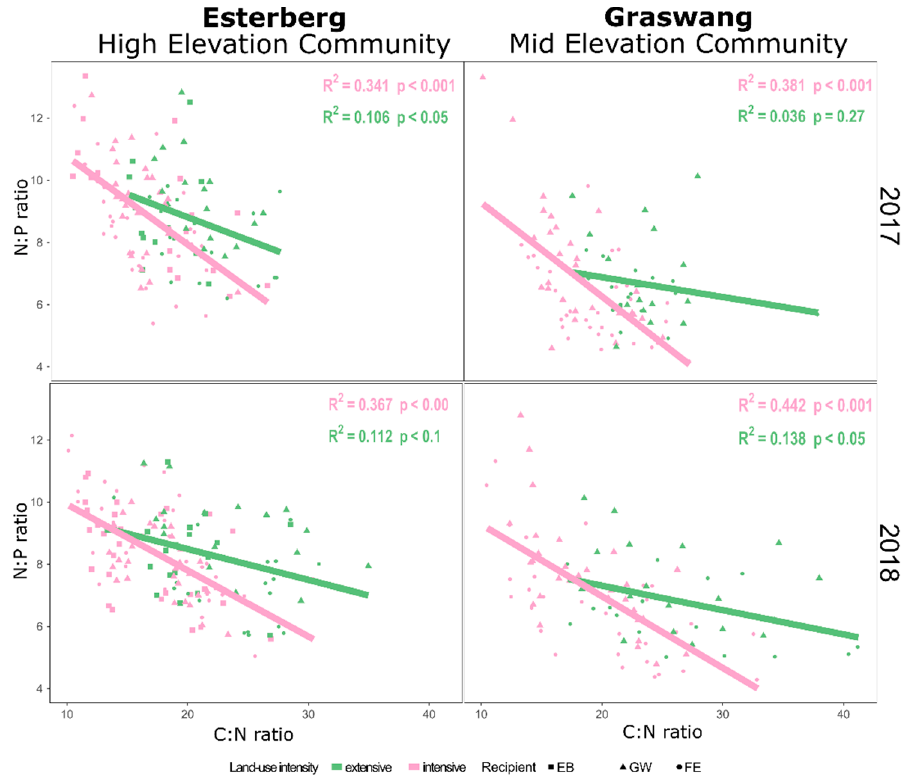
Figure 3. Relationship between C:N and N:P ratios of high-elevation (left column) and mid-elevation (right column) communities for 2017 (top row) and 2018 (bottom row).